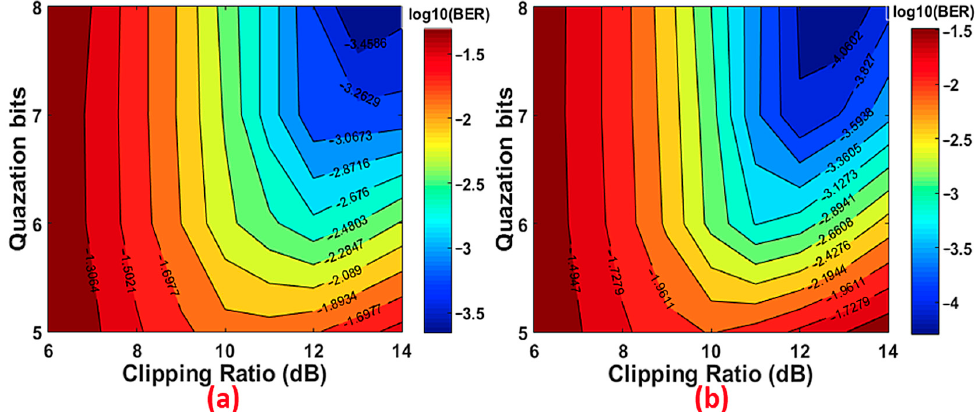
Figure 3. BER contour versus quantization bit resolution and clipping ratio for ( a ) excluding the DFT-spread, and ( b ) including the DFT-spread.